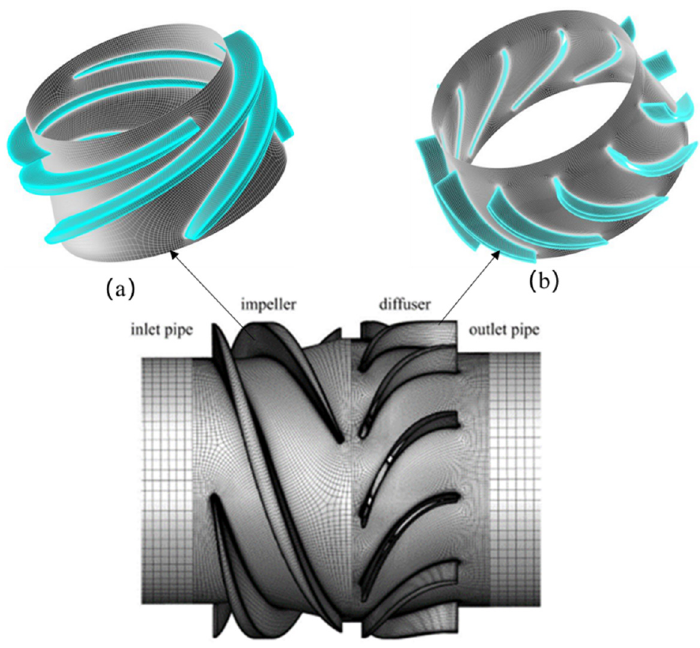
Figure 3. Computational meshes of the ( a ) impeller and ( b ) diffuser.